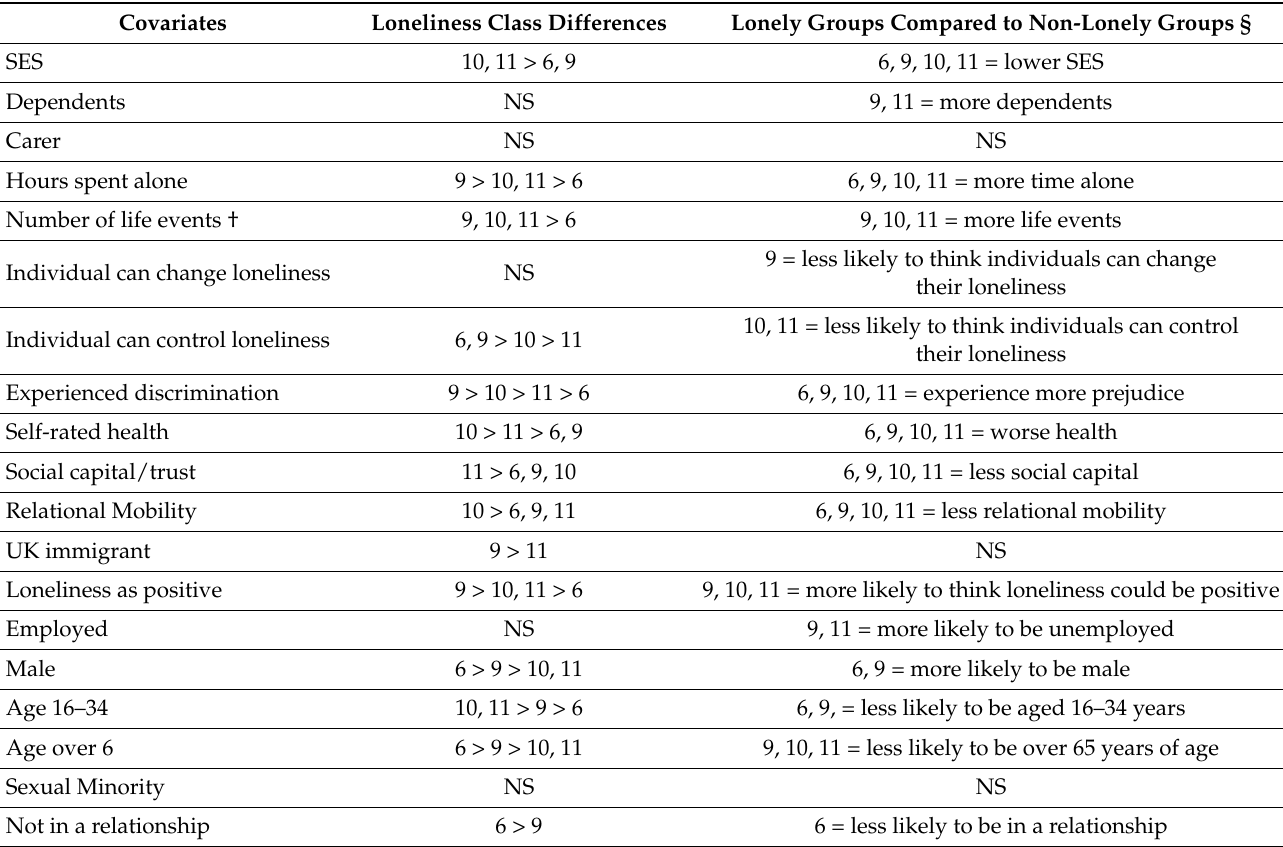
Table 7. Easy View: How are the lonely and non-lonely classes different to each other? What distinguishes one lonely class from the others?